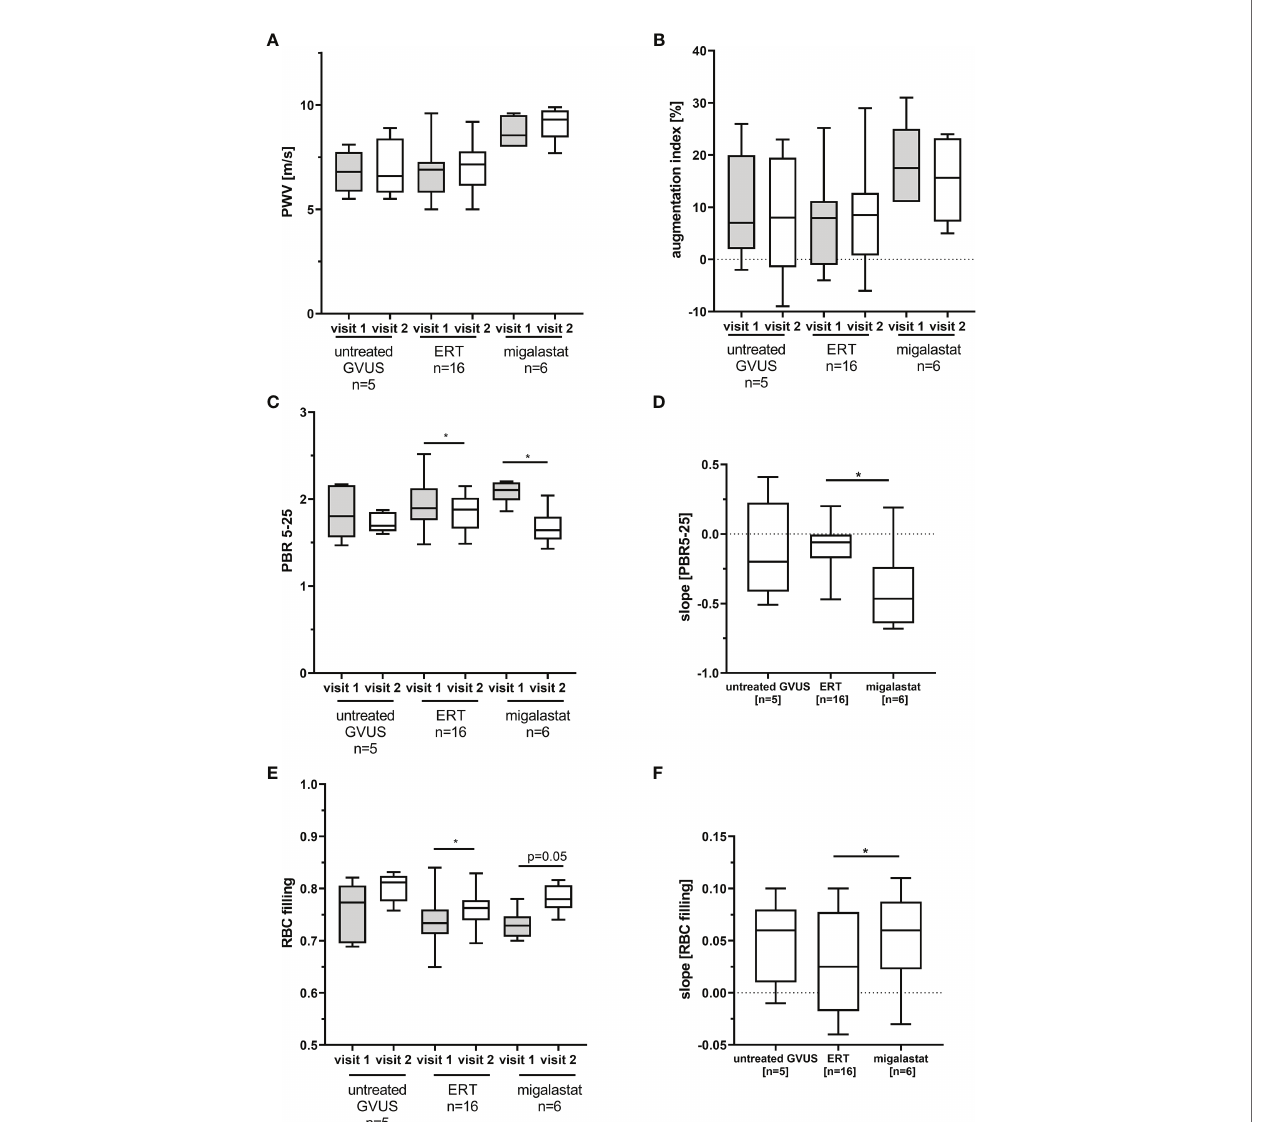
FIGURE 1 | Pulse wave velocity and glycocalyx measures in patients with FD. (A) Pulse wave velocity (PWV) and (B) augmentation index measures in FD patients and control patients with genetic variants of unknown signi fi cance (GVUS). (C) Perfused boundary region (PBR) in small vessels (5 to 25 µm in diameter). (D) Changes for PBR in one year. (E) Red blood cell (RBC) fi lling in small vessels. (F) Changes for RBC fi lling in one year. ERT, enzyme replacement therapy. *p < 0.05 determined by Kruskal-Wallis test or One-Way ANOVA. Visit 1: fi rst visit, study start, Visit 2: follow-up